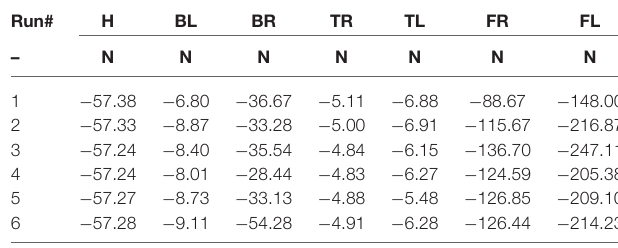
TABLE 1 | Testing sequence after level calibration. TABLE 2 | Calibrated sensor (tare) values of preliminary test runs